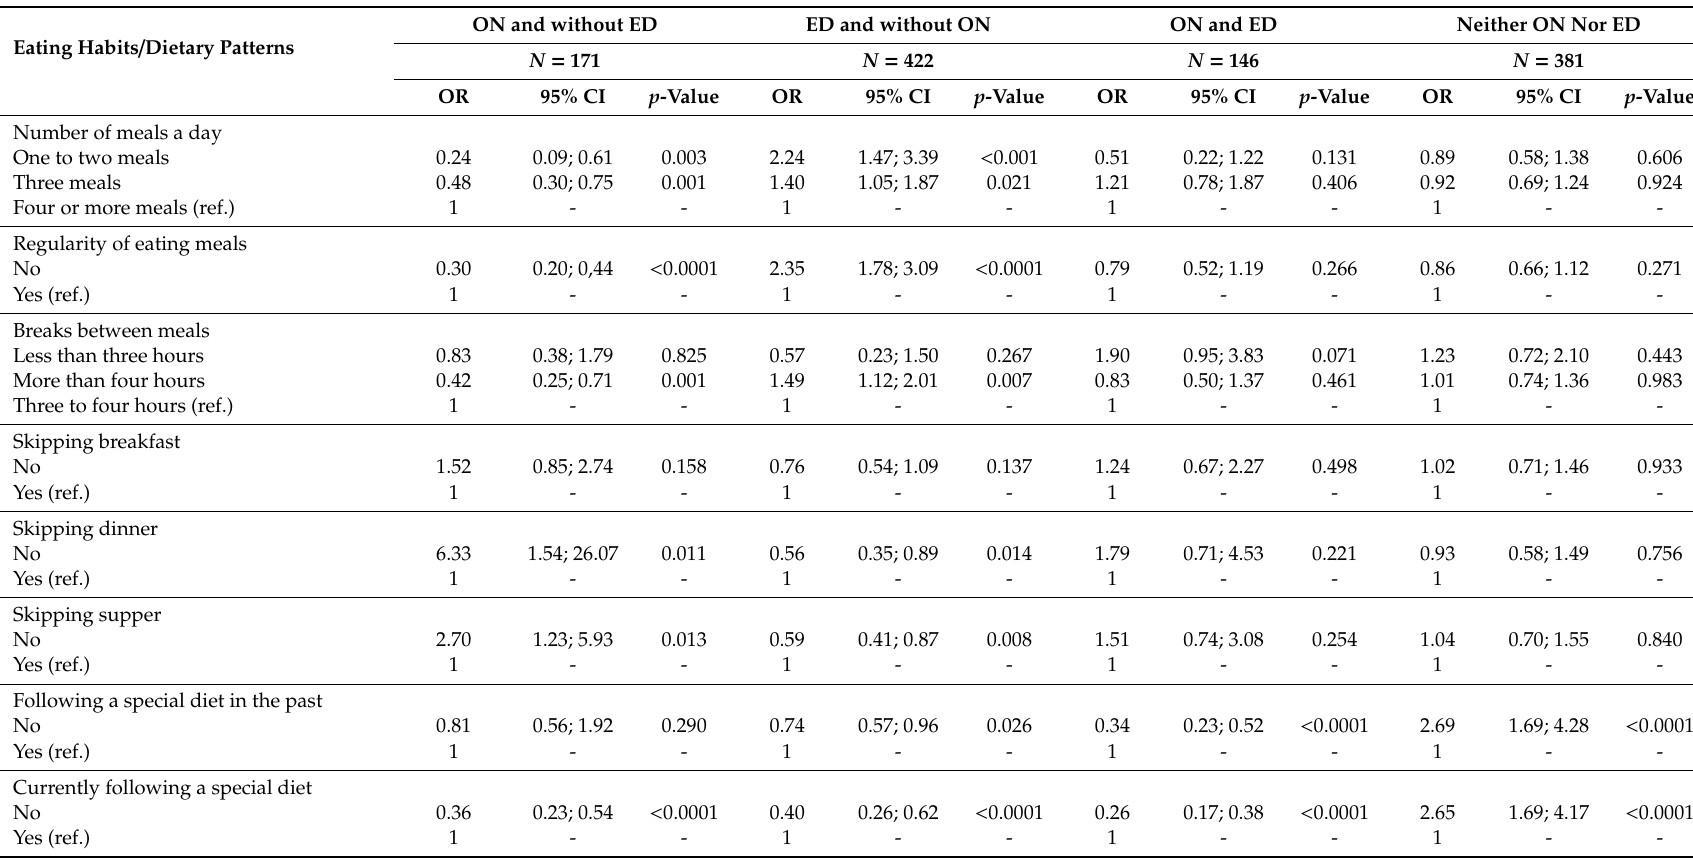
Table 4. Associations between orthorexia nervosa tendency and eating disorders symptoms by eating habits and dietary patterns (odds ratios with 95% confidence